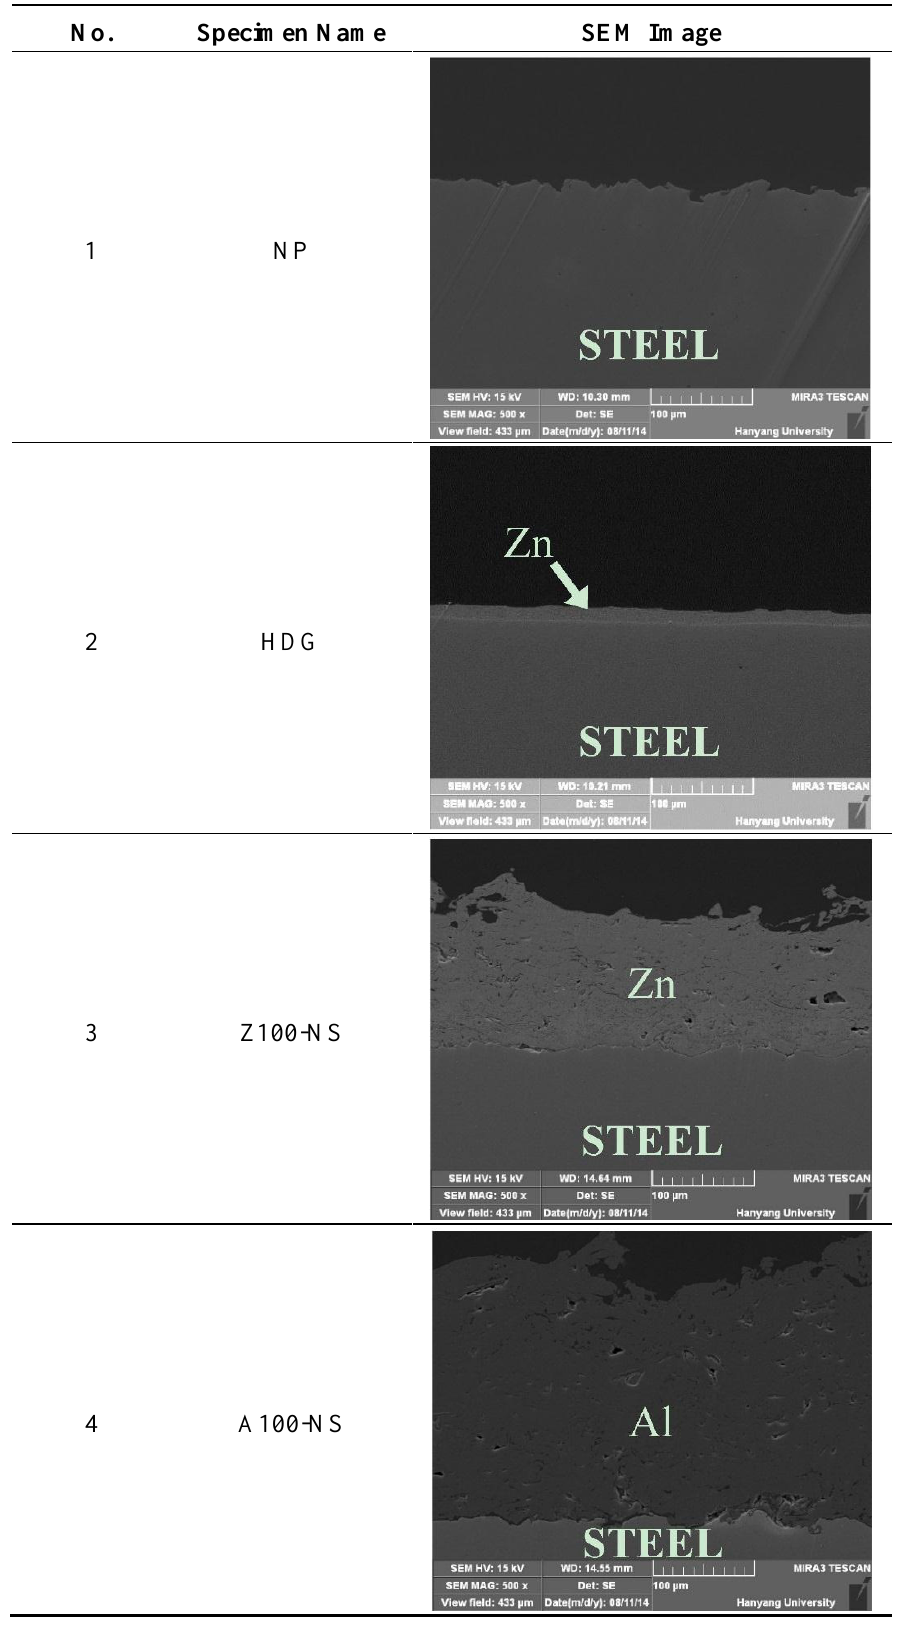
Table 2. SEM (scanning electron microscopy) images for each corrosion resistance method.